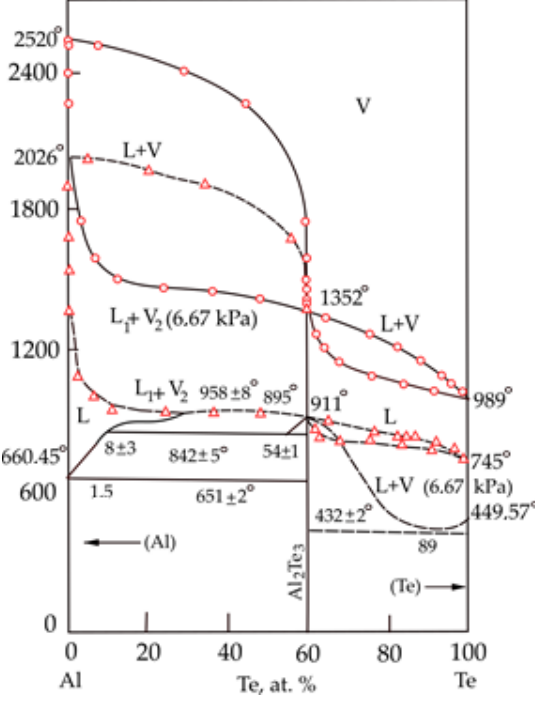
Figure 3. Full state diagram of the Al-Te system.